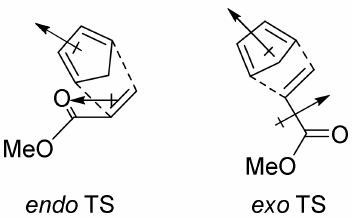
Figure 5. Endo - and exo -transition